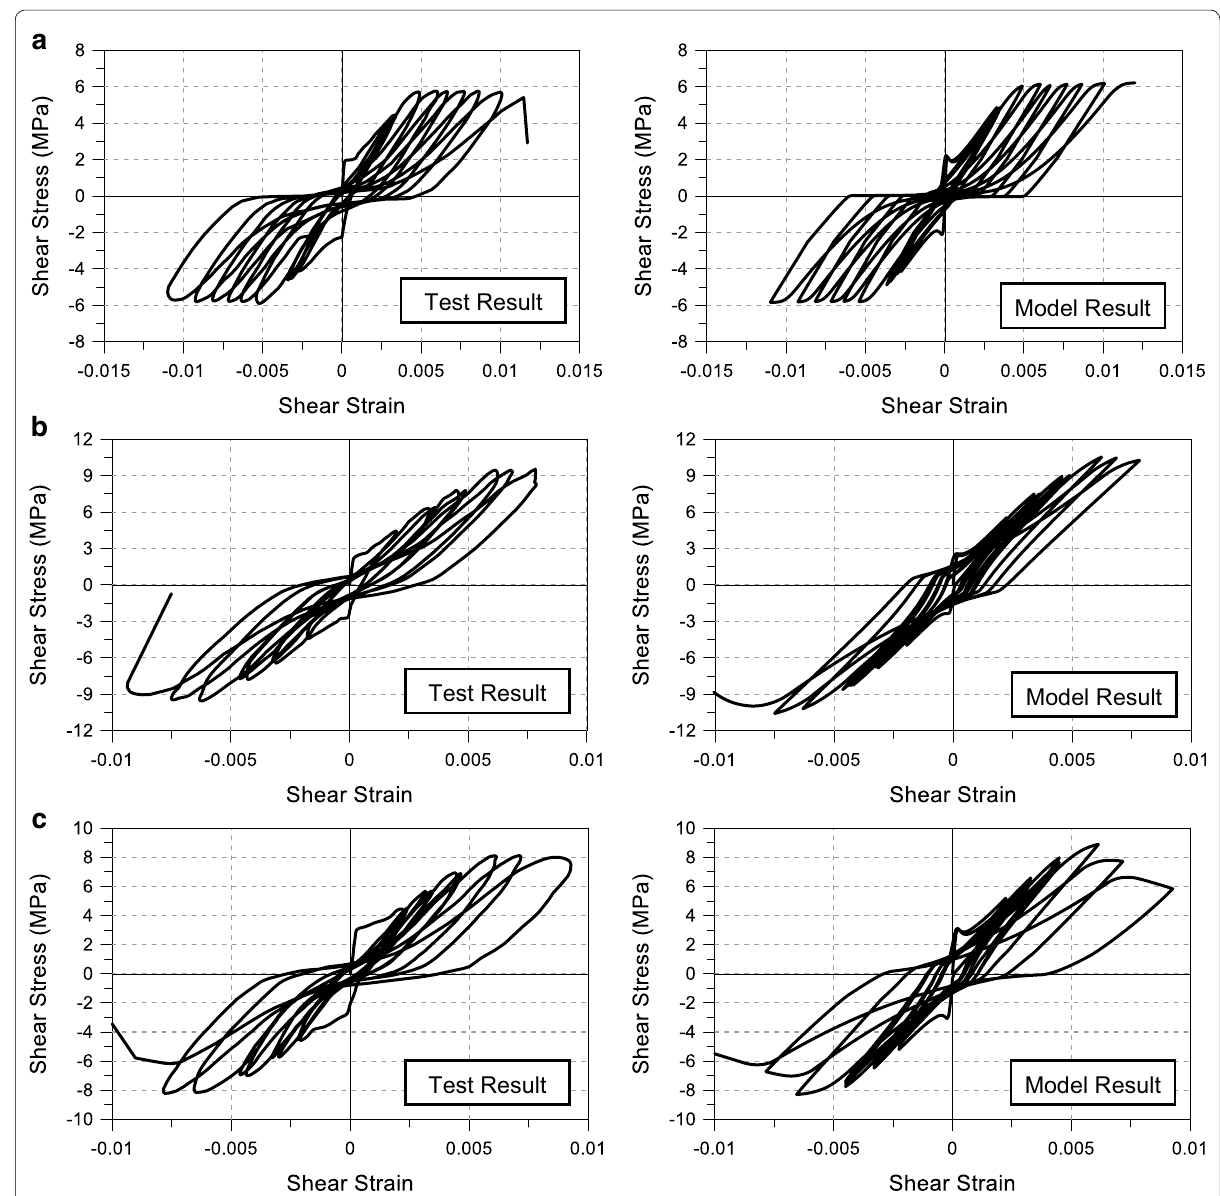
Fig. 4 Measured vs. predicted shear stress vs. shear strain responses: a Specimen SE8, b Specimen SE9, c Specimen